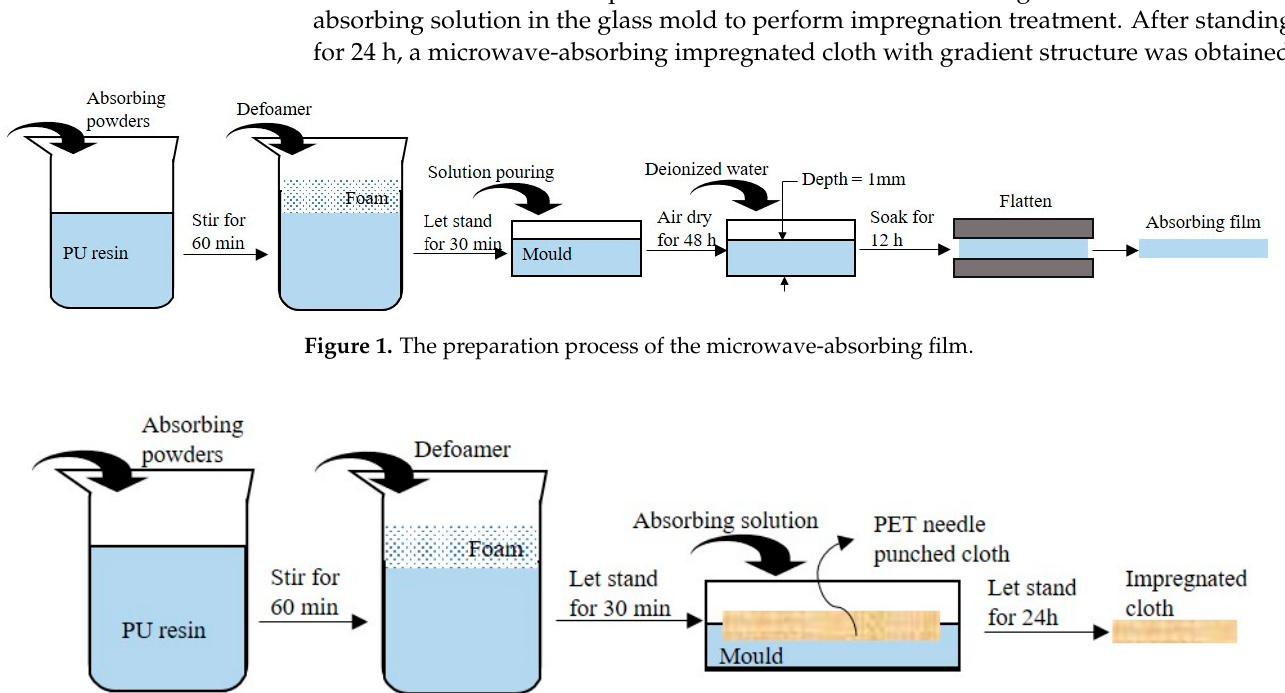
Figure 1. The preparation process of the microwave-absorbing film.